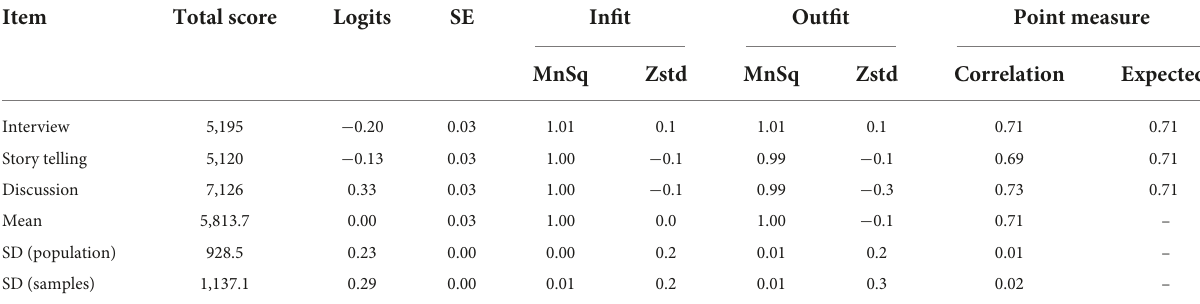
TABLE 2 Report on item